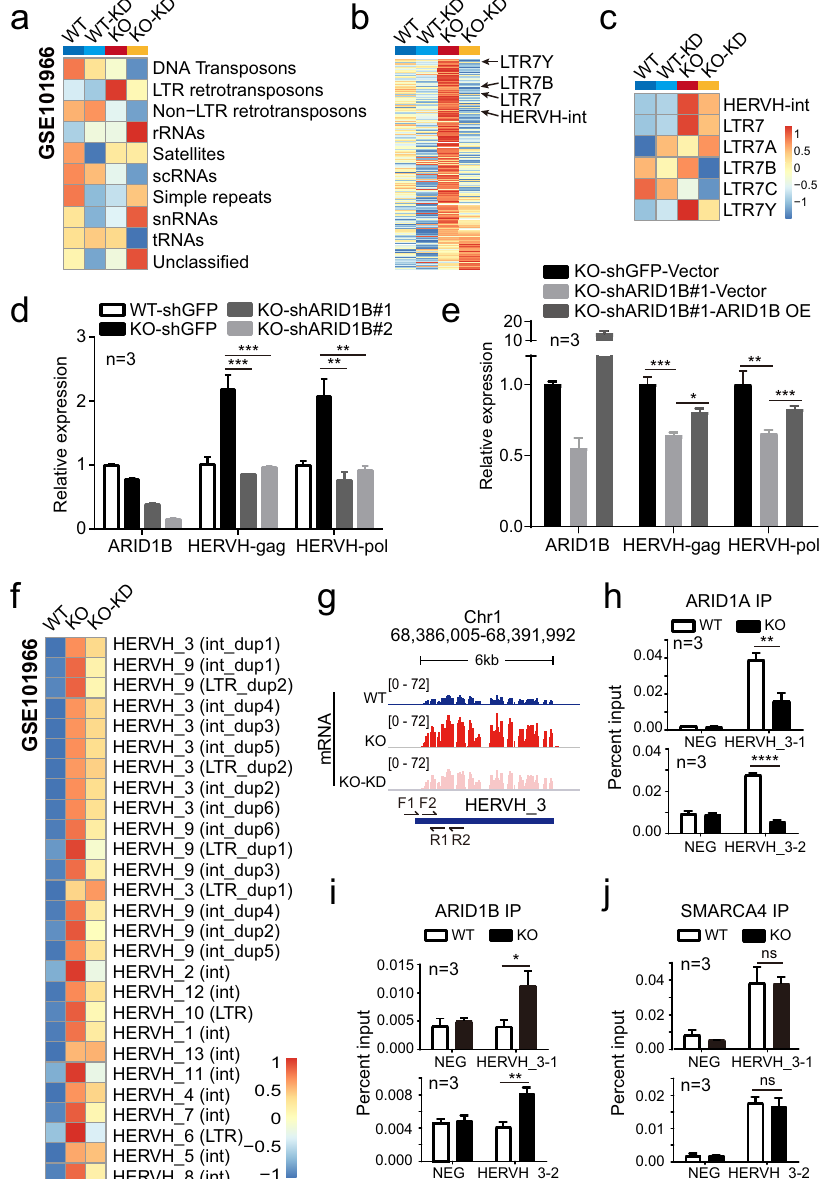
Fig. 3 ARID1B contributes to the upregulation of HERVH in the absence of ARID1A. a – c Heatmaps of the expression levels of different repetitive sequences in WT or ARID1A KO HCT116 cells treated with control or ARID1B (KD) shRNA generated with the GSE101966 dataset. d qPCR results showing the expression levels of ARID1B and HERVH in ARID1A WT or KO cells treated with shRNA targeting GFP or ARID1B. Two different shRNA sequences targeting ARID1B are used to exclude potential off-target effects. Data are presented as mean values ± SD from three independent experiments, two-tailed unpaired t test, ** p < 0.01, *** p < 0.001. e qPCR analysis of ARID1B and HERVH expression levels in ARID1A KO cells treated with the indicated shRNAs and overexpression plasmids. Data are presented as mean values ± SD from three independent experiments, two-tailed unpaired t test, * p < 0.05, ** p < 0.01, *** p < 0.001. f Heatmap showing the expression levels of the derepressed HERVH loci (27) in ARID1A KO cells determined by DESeq2 (version v1.22.2, with two-tailed likelihood ratio test, using cut-off values of adjusted p value <0.05 and |Log2 FC | > 0.585). The majority of them (25) display reduced expression when ARID1B is knocked down (KO-KD). g Genomic snapshot of RNA-seq signals at a representative HERVH locus ( HERVH_3 ). Two primer sets targeting this locus for ChIP-qPCR analysis are shown. h – j ChIP-qPCR results with two different primer sets showing decreased ARID1A and increased ARID1B at the HERVH_3 locus in ARID1A KO cells, whereas the amount of another BAF component SMARCA4 remains unchanged. Data are presented as mean values ± SD from three independent experiments, two-tailed unpaired t test, ns: not signi fi cant, * p < 0.05, ** p < 0.01, **** p < 0.0001. Source data including exact p values are provided as a Source data fi